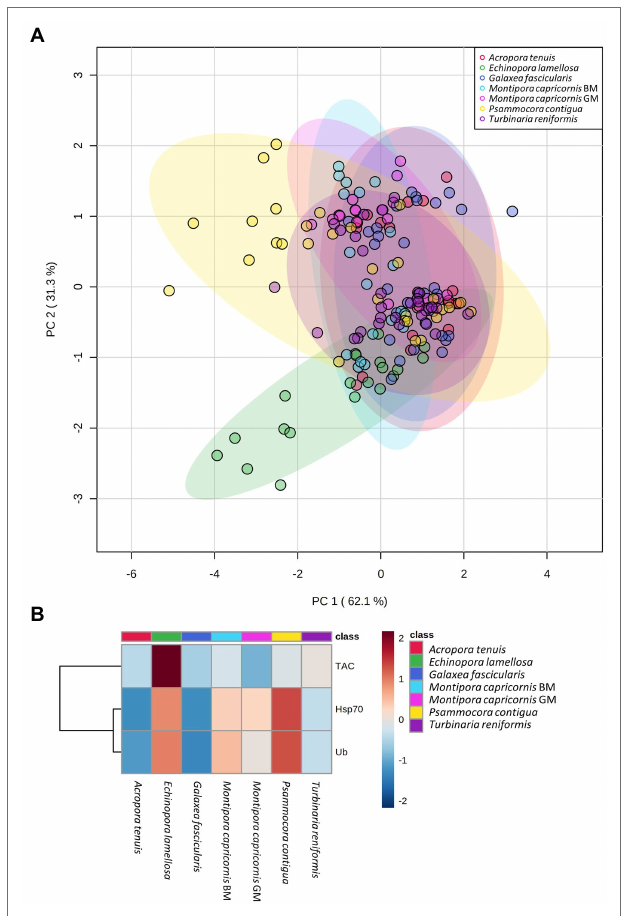
FIGURE 3 | Differences in biomarker profiles of corals with tissue wound lesions from predation vs. no tissue lesions. (A) PCA score plot of biomarker profiles; (B) heatmap of clustered biomarkers; in the color scale, red indicates higher than mean concentration, and blue indicates lower than mean concentration. Rows are biomarker concentrations and columns are group averages. Significant differences were found for biomarker profiles between predation conditions ( Table 2